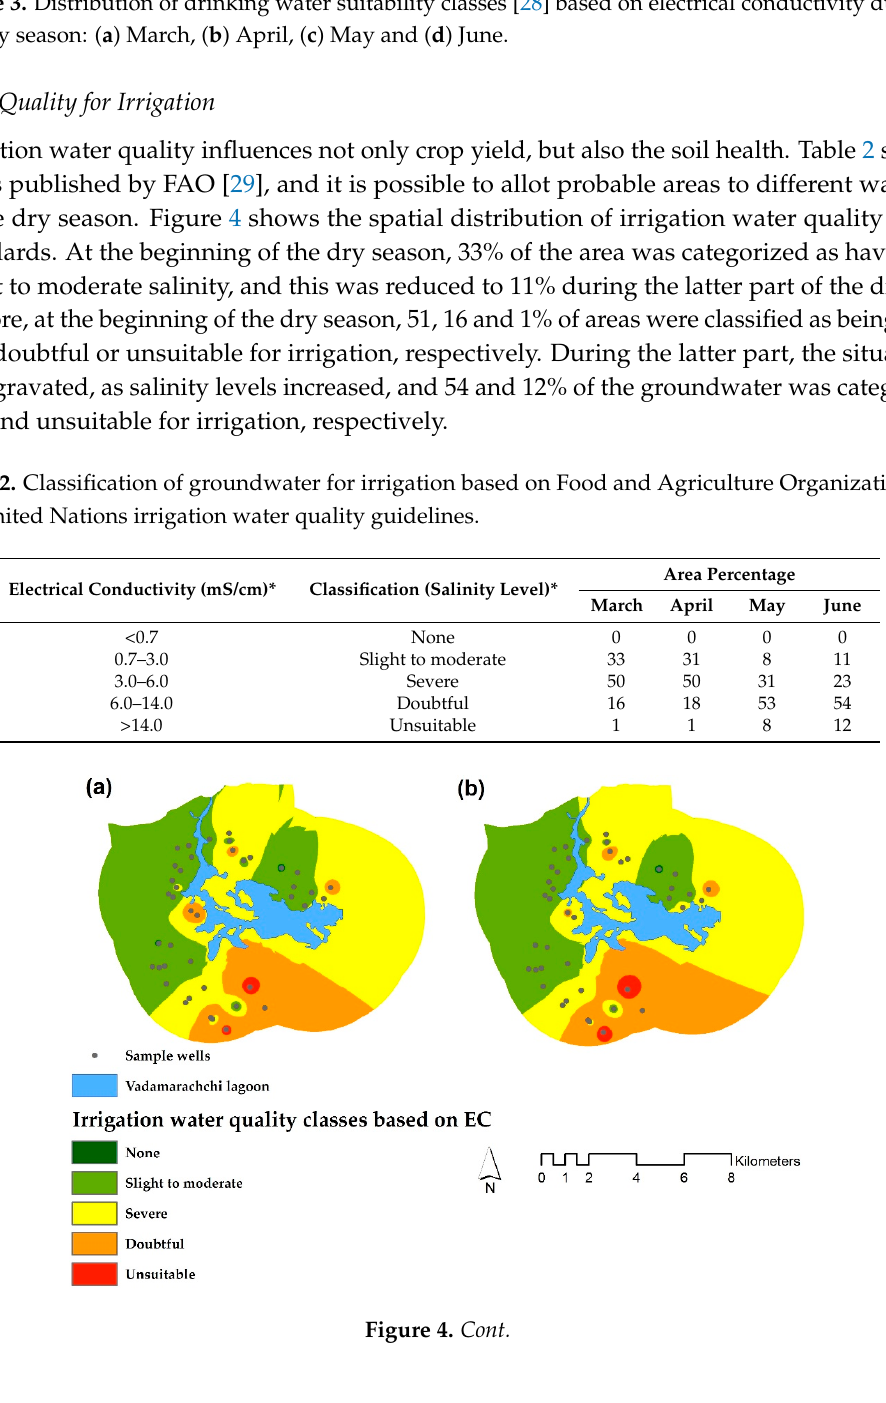
Figure 4. Distribution of irrigation water quality classes based on electrical conductivity during the dry season: ( a ) March, ( b ) April, ( c ) May, and ( d ) June, based on Food and Agriculture Organization of the United Nations irrigation water quality guidelines [29]. 3.3. Groundwater Availability As shown in Figure 5, shallow groundwater levels were observed in proximity to the lagoon. With the small amount of rainfall received during May, groundwater levels rose, especially in the south and southwestern parts of the study area. The southern part of the study area, sandwiched